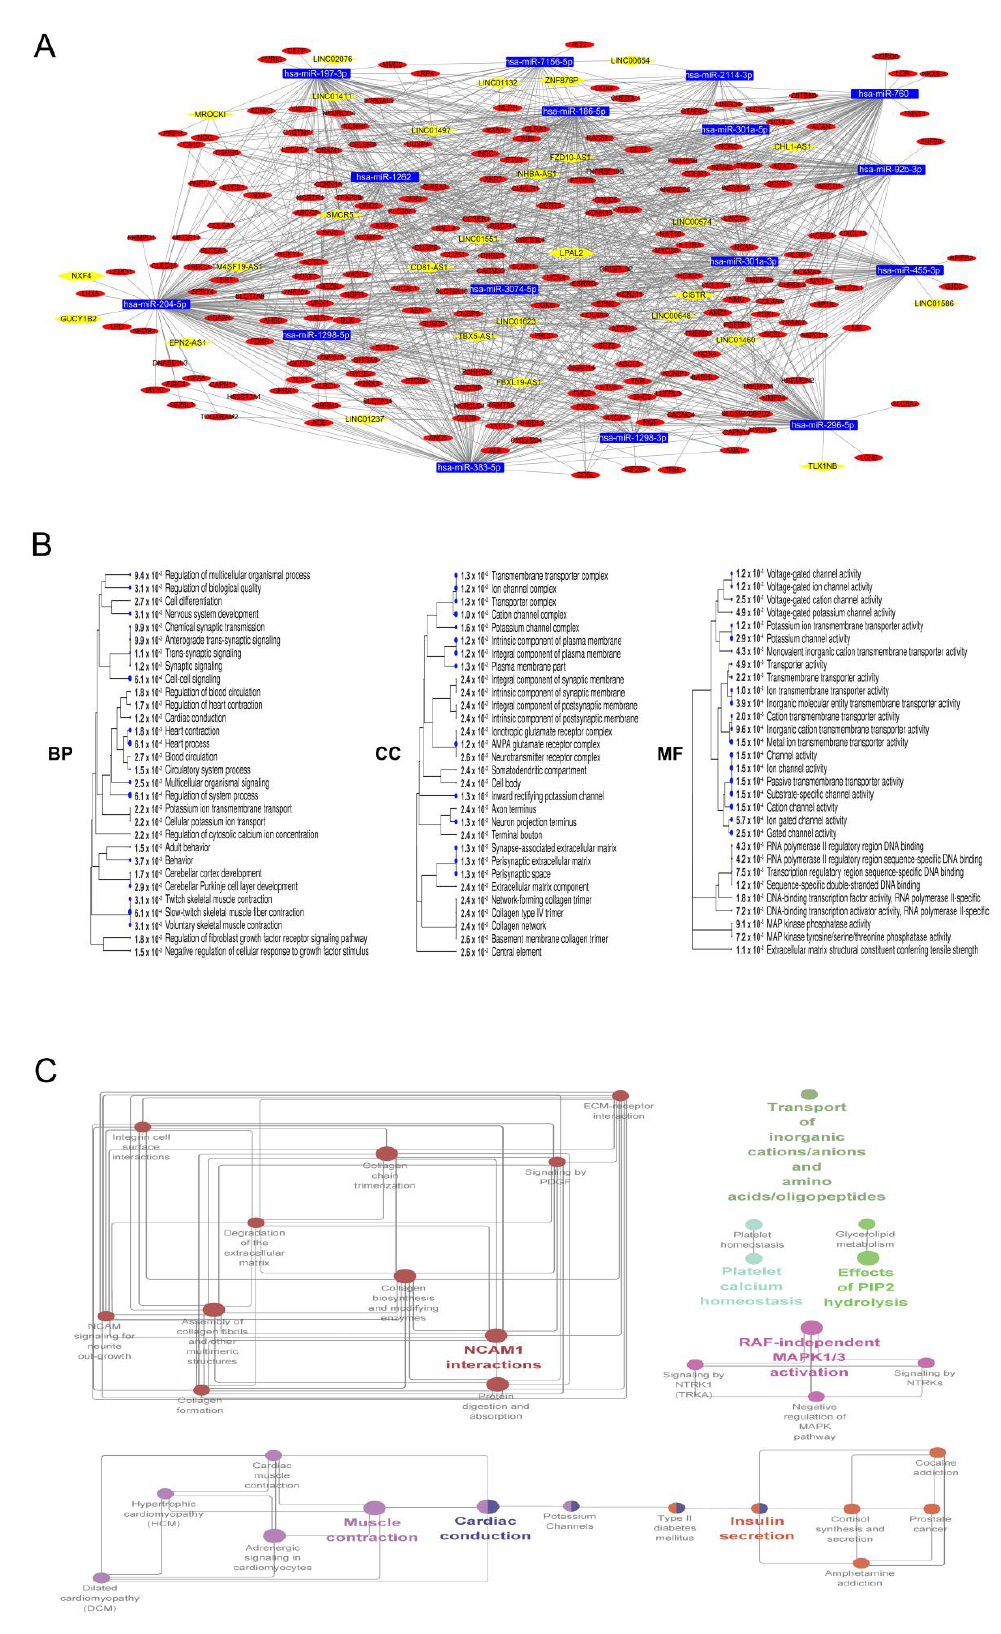
Figure 4. Construction and biological identification of the ceRNA network comprising upregulated DEcodingRNAs and DEncRNAs expected to be candidate targets of downregulated